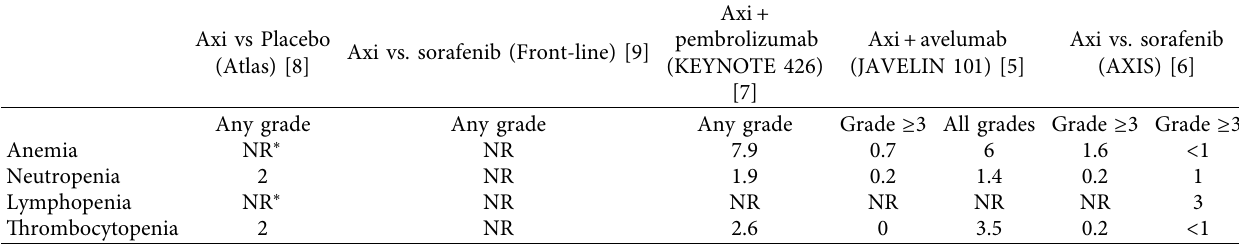
Table 1: Hematologic adverse effects in major trials of Axitinib.